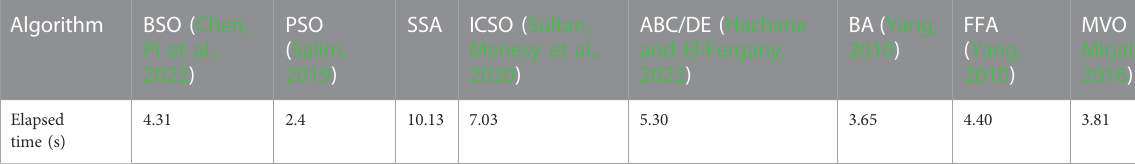
TABLE 4 The Elapsed time for the state-of-the-art methods on the NedS stack PS6. Algorithm